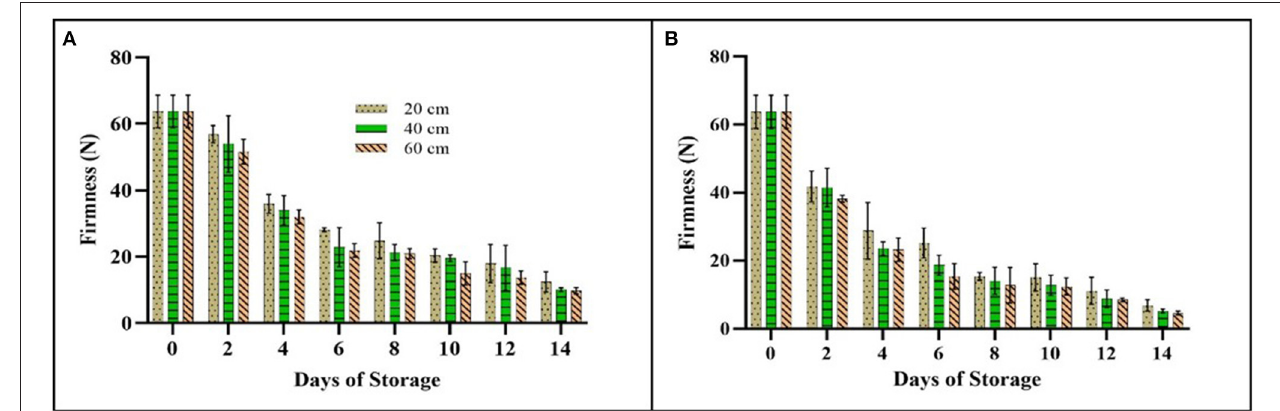
FIGURE 10 | Firmness (N) of pear impacted at different drop heights (20, 40, and 60cm) during 14 days at (A) 10 ◦ C and (B) 22 ◦ C storage conditions. The data were expressed in mean ± standard deviation. Error bars represent the standard deviation (S.D.) of the mean values ± S.D. of six readings per three replicates.